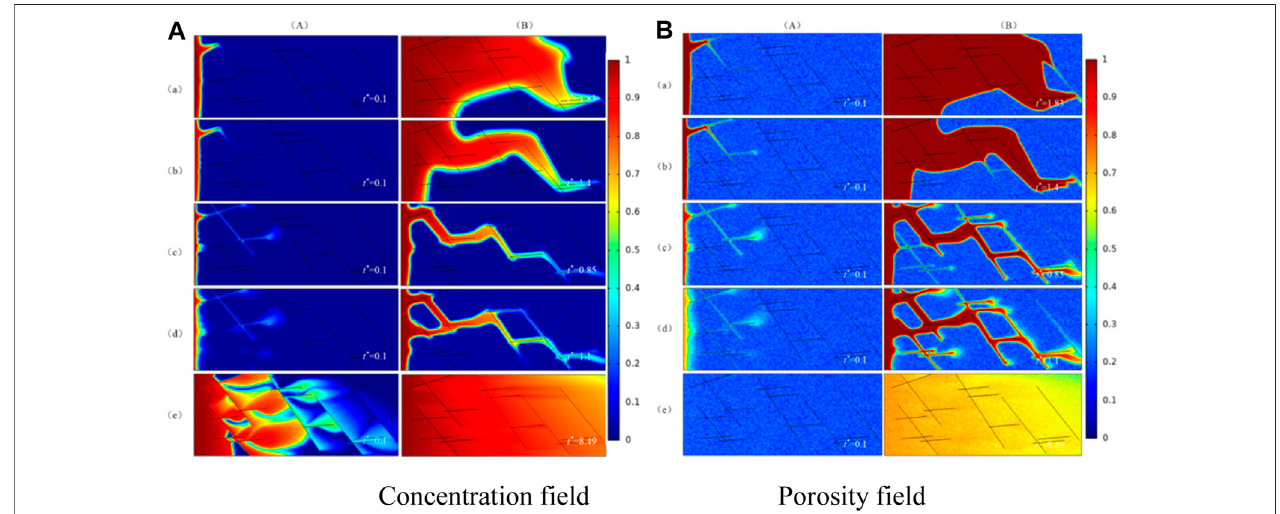
FIGURE 4 | Dissolution patterns of different Damkohler numbers. (a) Face dissolution, Da (cid:1) 2,000; (b) Concial dissolution, Da (cid:1) 1,000; (c) Wormhole, Da (cid:1) 250; (d) Branching dissolution, Da (cid:1) 100; (e) Uniform dissolution, Da (cid:1) 1. (A) The initial phase; (B) The dissolution structure when injected acid breaks through the core.